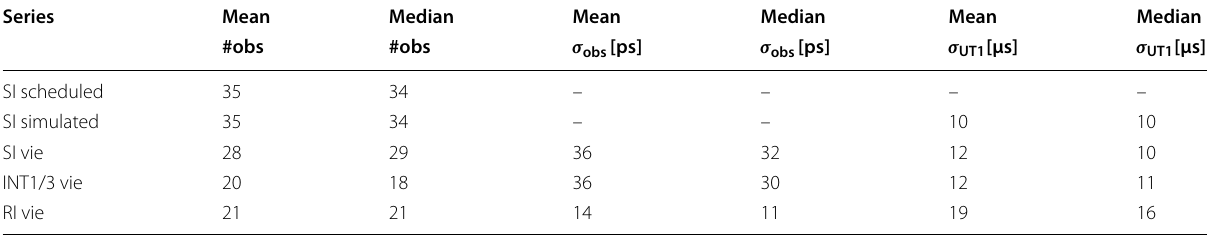
Table 1 Mean and median values of the number of observations normalised by the number of baselines (#obs), of the formal errors of the observations ( σ obs ) and of the formal errors of the UT1